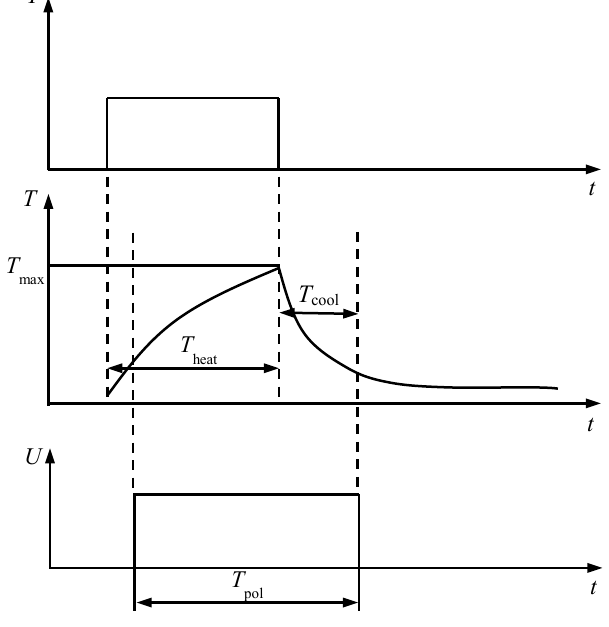
Fig. 3. Diagram of parameter change in the process of CPT